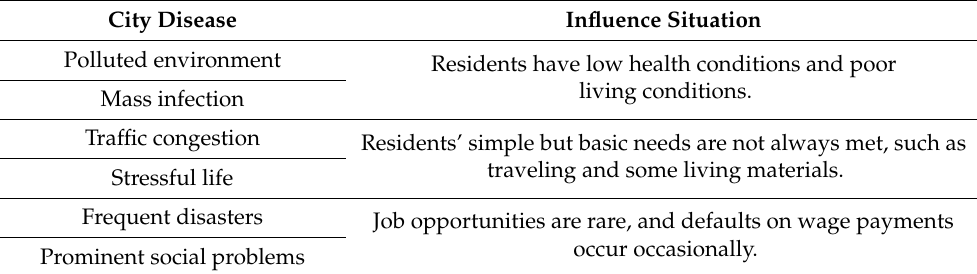
Table 1. Difficulties in creating healthy